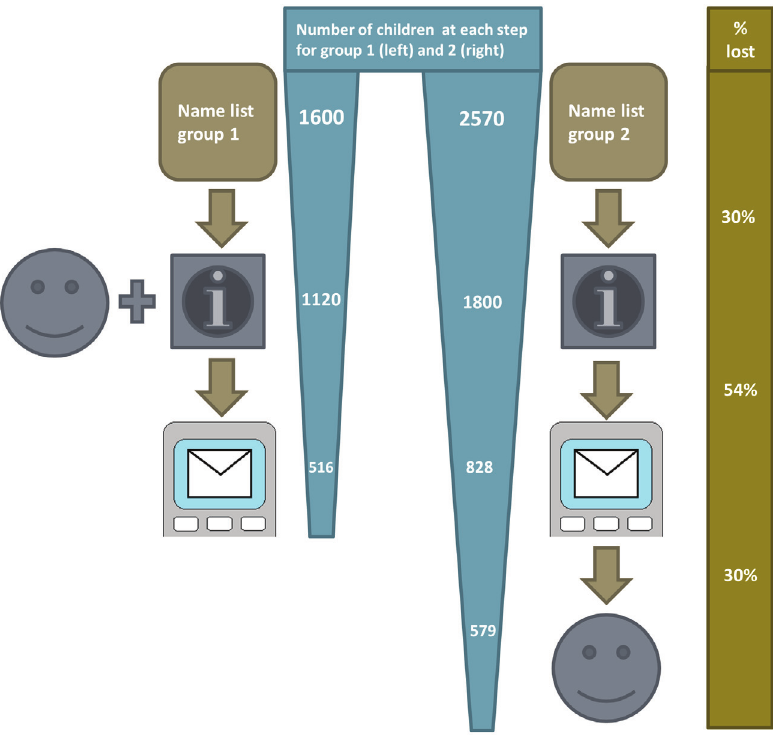
Figure 4. Rough estimation of the expected number of participants of cross–over study. Letter clipart indicates those expected to complete informed consent and collection of demographic and mobile phone use information; face clipart indicates those expected to complete interviewer–administered face–to–face survey on childhood diarrhoea and pneumonia; mobile phone clipart indicates those expected to complete at least one question from self–administered text messaging survey on childhood diarrhoea and pneumonia. Images were created in Microsoft PowerPoint 2010 or